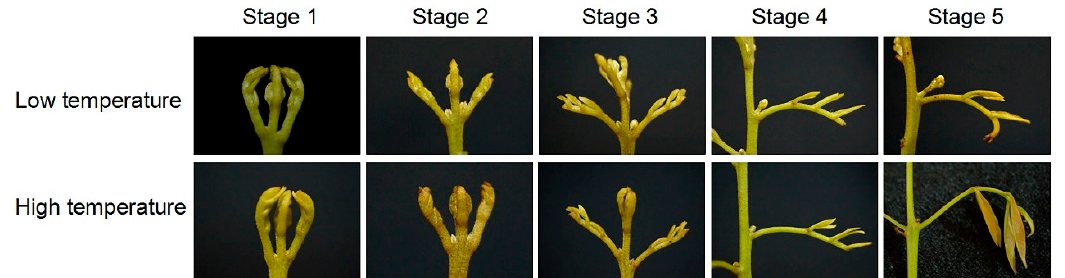
Figure 1. The phenotype of five developmental stages of panicle leaves in litchi trees subjected to low or high temperatures. Litchi trees were transferred to a growth chamber at 18 °C as low temperature treatment to induce panicle leaf senescence when panicle primordia emerged. The other trees were transferred to a growth chamber at 26 °C as high temperature to encourage panicle leaf development.